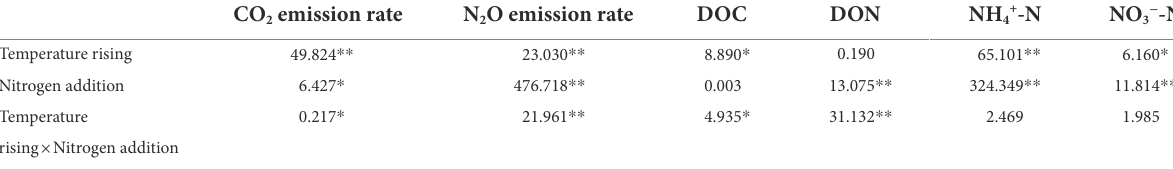
TABLE 1 Two-way ANOVA of effects of temperature rising and nitrogen addition on soil CO 2 , N 2 O release, and soil carbon and nitrogen contents.